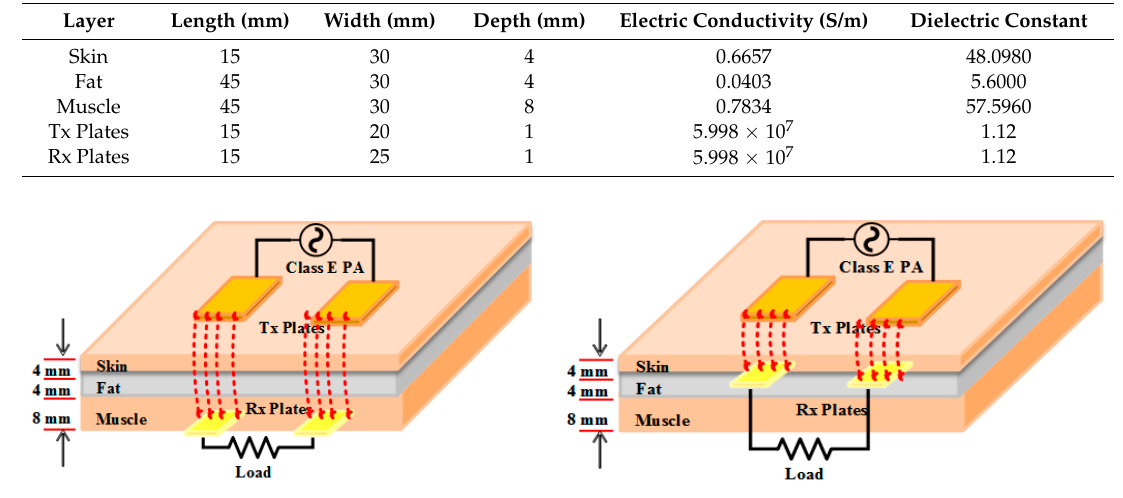
Table 3. Tissue layers dimensions and properties.